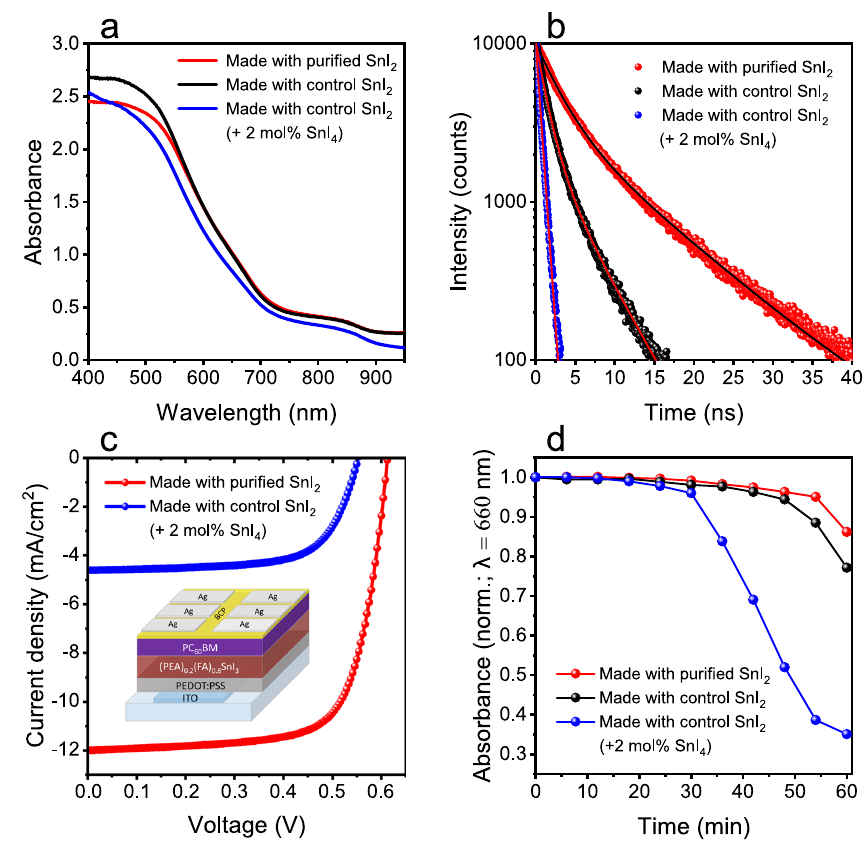
Fig. 3 Effect of tin (IV) iodide on Sn perovskite optical properties, solar cell performance and stability. a UV – Visible spectra of glass/ (PEA) 0.2 (FA) 0.8 SnI 3 thin fi lms made with varying SnI 4 concentrations. b Time-resolved PL decays of perovskite fi lms acquired at 875 nm with 404 nm excitation and their fi tting curves. Average τ f for fi lms are 5.49 ns ( fi lm made with puri fi ed SnI 2 ; biexponential decay fi t), 2.09ns ( fi lm made with control SnI 2 ; biexponential decay fi t) and 0.60 ns ( fi lm with added SnI 4 ; monoexponential decay fi t). c . Current density – voltage (J – V) curves of champion solar cells based on (PEA) 0.2 (FA) 0.8 SnI 3 made with varying SnI 4 concentrations. d . Time evolution of relative absorbance at 660 nm of perovskite thin fi lms made with varying SnI 4 concentrations. Degradation experiments were carried out under dark and ambient air conditions (23 °C, 38%